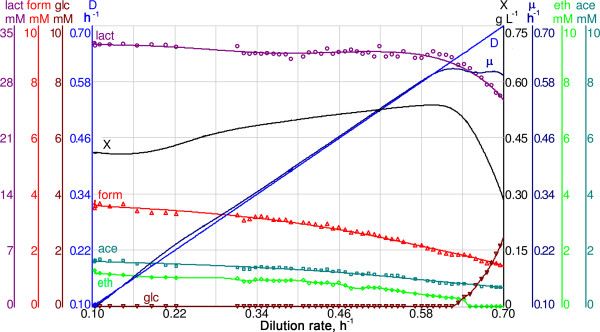
Typical A-stat cultivation, where dilution rate dependent metabolism of L. lactis is illustrated. D - dilution rate (h-1); X - biomass concentration (g (dry cellular weight) L-1); μ - specific growth rate (h-1); lact, form, glc, eth, ace - lactate, formate, glucose, ethanol, acetate concentration in bioreactor, respectively (mM). D, μ and X are monitored constantly; metabolite concentrations are measured with a frequency of approximately 0.01 h-1.